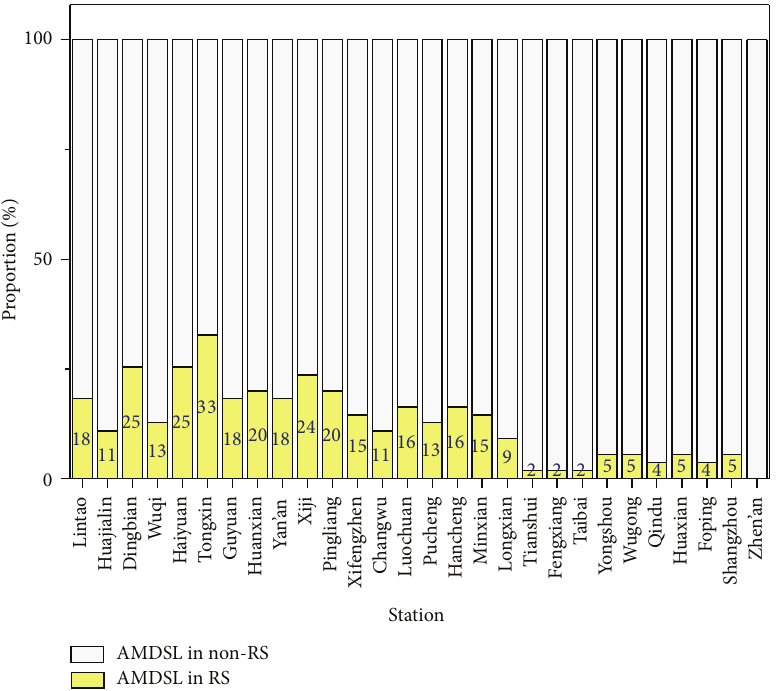
Figure 4: The proportion of the longest dry spell occurred during RS and non-RS during 1960–2014 in the WRB.